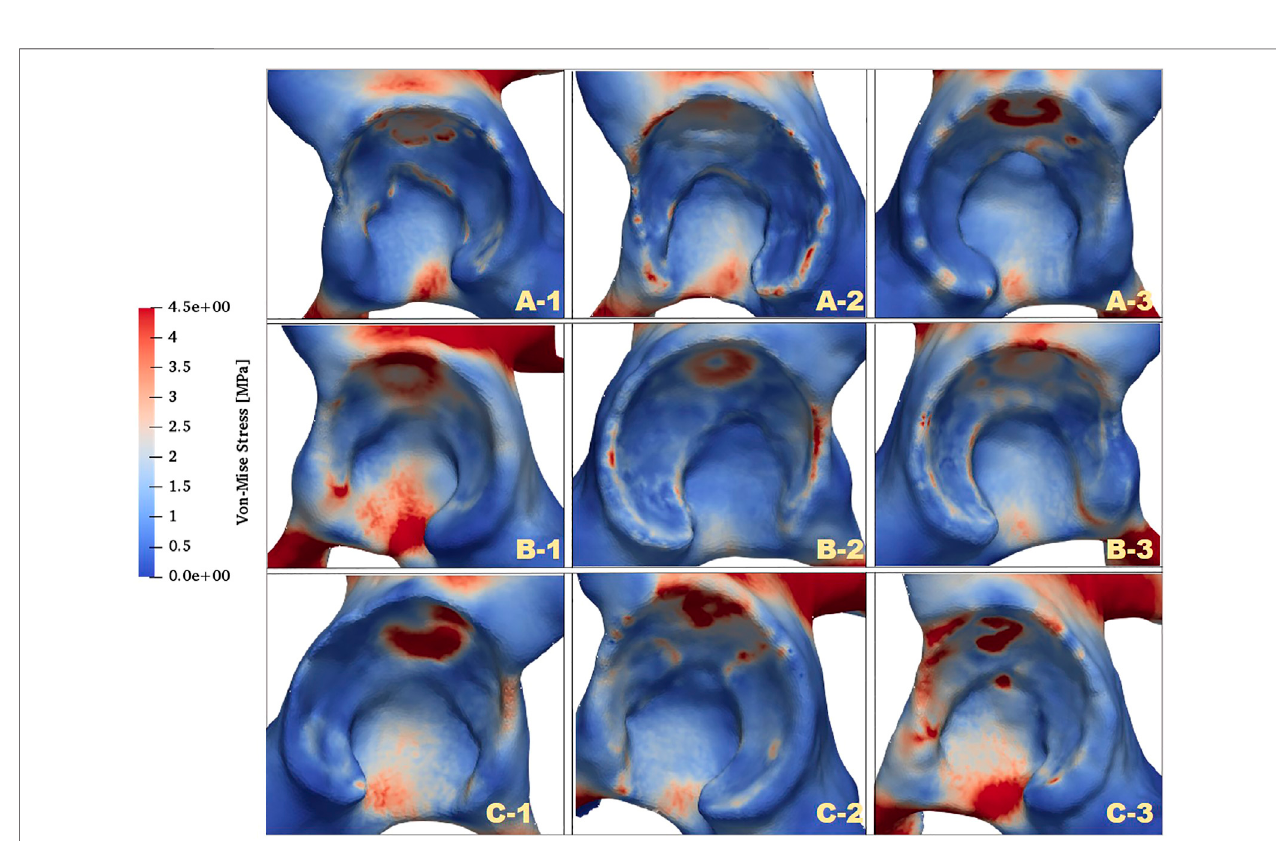
FIGURE 4 | Comparison of stress distributions of the acetabulum at different LCEA and ACEA angles.